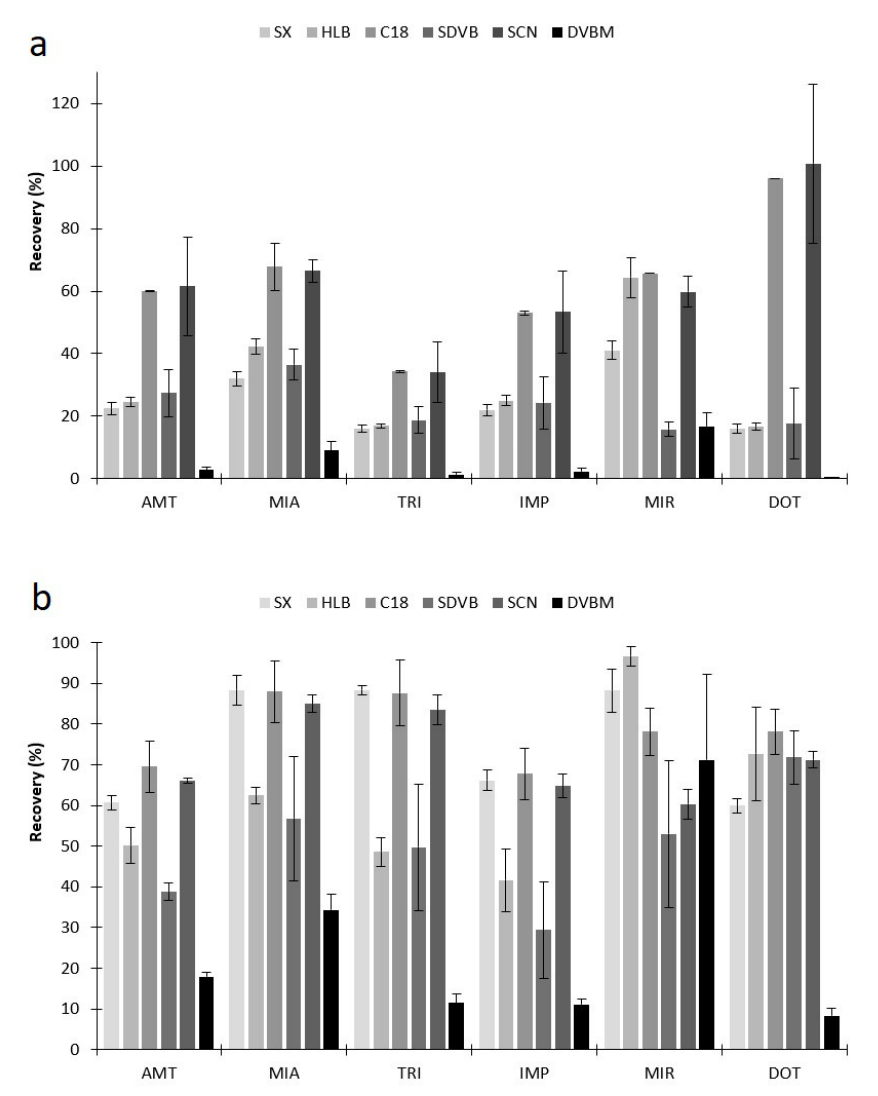
Figure 3. Effect of MeOH ( a ) and MeOH:ACN mix ( b ) stripping solvents on the back-extraction of the six TCAs from the different polymer phases by BAμE-μLD/LVI-GC-MS(SIM). The error bars represent the standard deviation of three repli- cates.